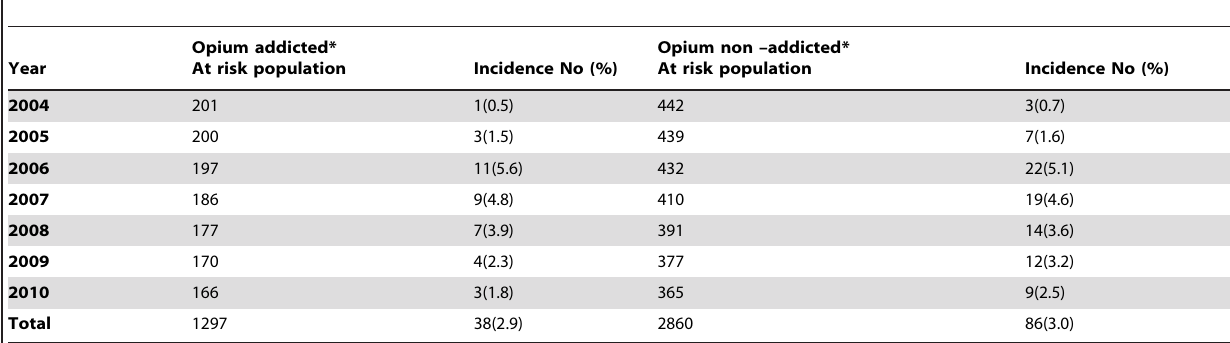
Table 3. The incidence of cutaneous leishmaniasis cases in opium addicted and non – addicted cohorts by the year of